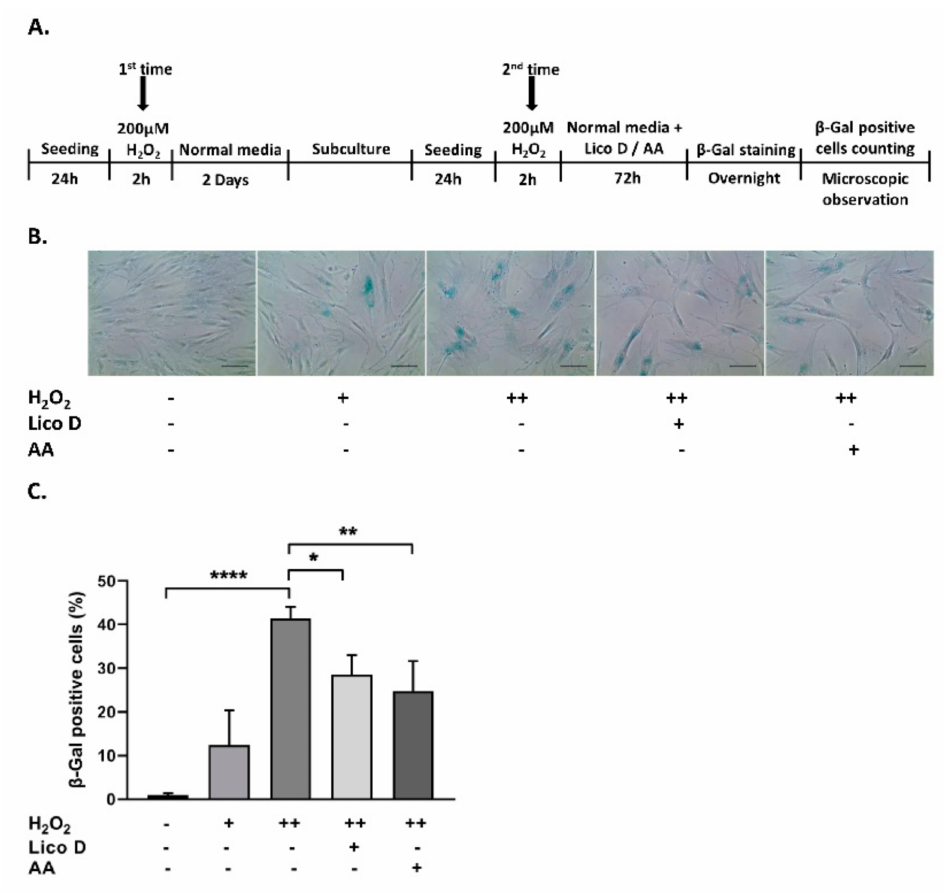
Figure 2. Effect of Lico D in oxidative stress induced senescent hBM-MSCs. ( A ) Graphical representa- tion of the oxidative stress induced senescence in hBM-MSCs. ( B ) Representative image of SA- β -gal positive cells and ( C ) percentage of SA- β -gal positive cells in oxidative stress induced senescence model. H 2 O 2 (+) represents one-time treatment and H 2 O 2 (++) represents double time treatment. The scale bar represents 100 µ m. All data are represented as mean ± SD ( n = 3) * p < 0.05, ** p < 0.01, and **** p <